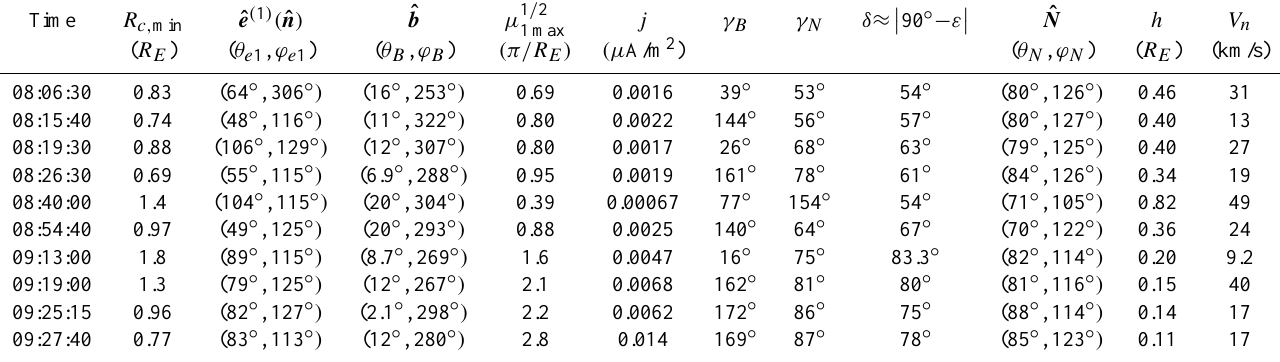
Table 2. The parameters of the magnetic field at the center of the neutral sheet during the series of CS crossing events on 3 August 2004.